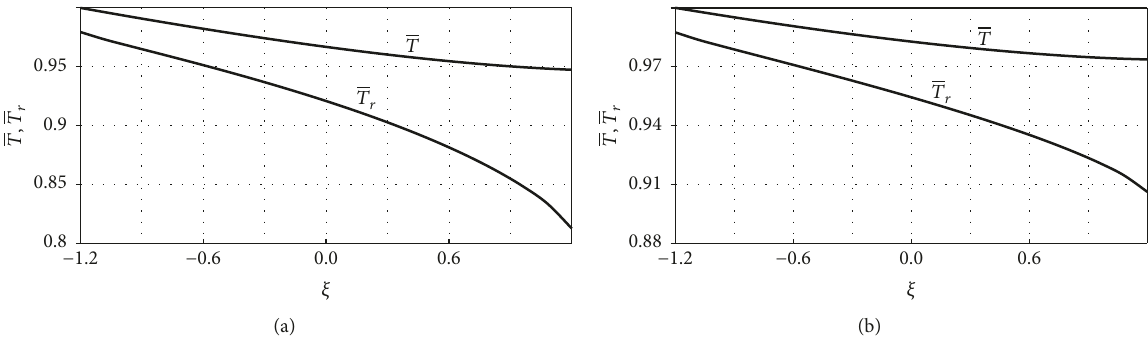
Figure 2: Dependencies of dimensionless temperature 𝑇 and radiation temperature 𝑇 𝑟 on spatial coordinate for two different values of hemispherical emissivity 𝜀 1 : ( 1 ) – 𝜀 = 0.2 ; (b) 𝜀 = 0.5 .